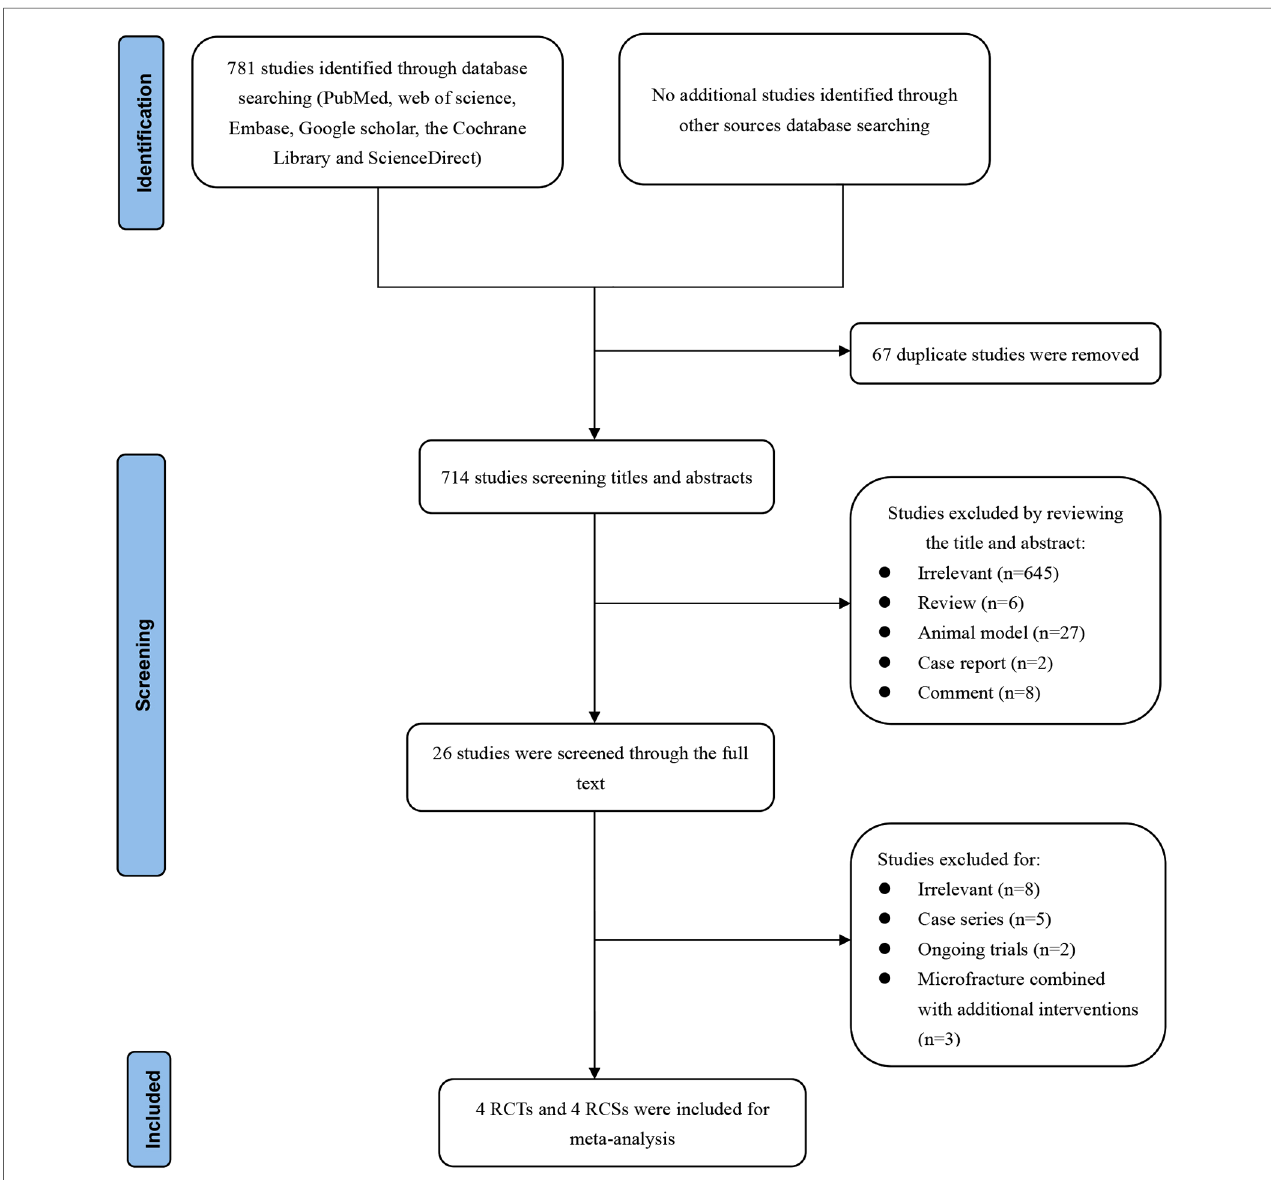
FIGURE 1 Preferred reporting items for systematic reviews and meta-analyses diagram on article selection for systematic